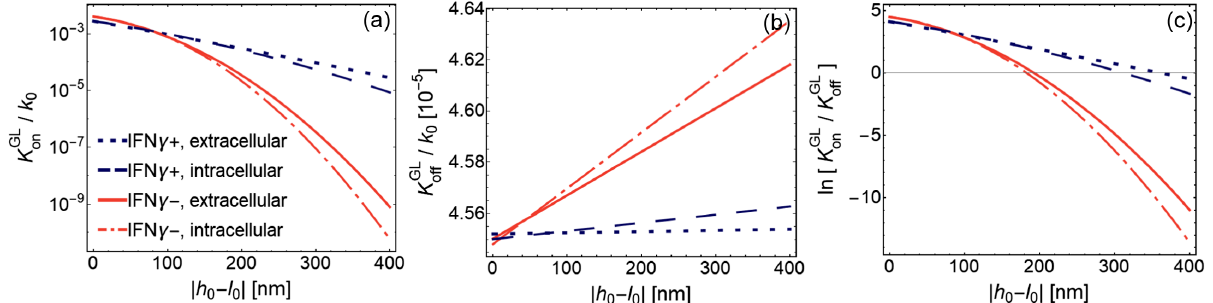
FIG. 8. Coarse-grained model for the ligand-receptor complexation in active (blue) and resting (red) macrophages as a function of the separation between the cell membrane and the target h 0 − l 0 on the extracellular (solid lines) and intracellular sides (dashed lines). (a) Binding rate K GL [Eq. (29)] is increased for orders of magnitude with activation, while the intracellular K GL is consistently smaller on on than the extracellular K GL . (b) The unbinding rate K GL [Eq. (31)] decreases with activation, but the effect is only small. Nonetheless, the on off =K GL (cid:2) increases drastically with is systematically larger than the extracellular K GL . (c) The effective affinity ln ½ K GL intracellular K GL on on off off activation, and the decay in the bond stability as a function of the distance from the target is significantly slower in activated cells compared to resting cells, with the range of extracellular affinity being larger than the intracellular one. We use the parameters α ¼ 0 . 5 nm and ϵ ¼ 10 . The values for λ λ k b 0 serves as G (cid:3) and L (cid:3) are taken from the experimental fits shown in Fig. 6. The intrinsic rate an unspecified unit for the